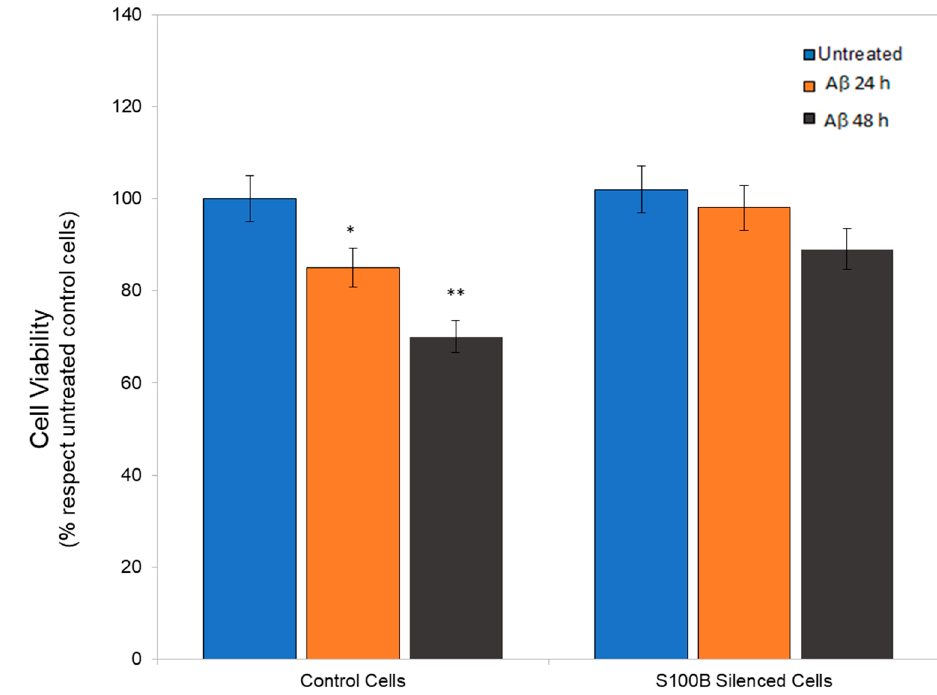
Figure 3. Cell viability for control and S100B-silenced cells after treatment with 10 µ M A β , for 24 h (orange bars) and 48 h (black bars), or in the absence of A β (blue bars). Data are expressed as a percentage relative to the untreated cells (100%). * p < 0.05 and ** p < 0.001 vs. untreated.